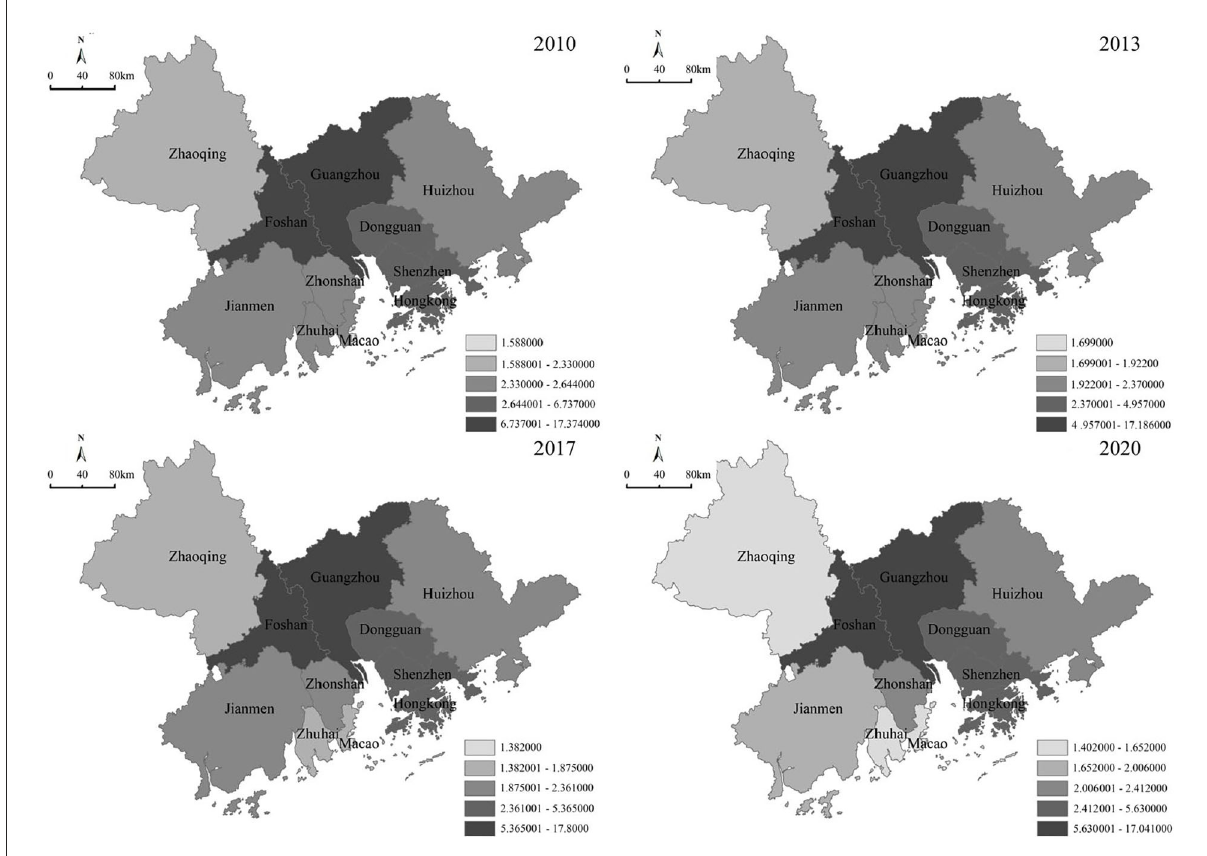
FIGURE7 Network centrality of the GBA.